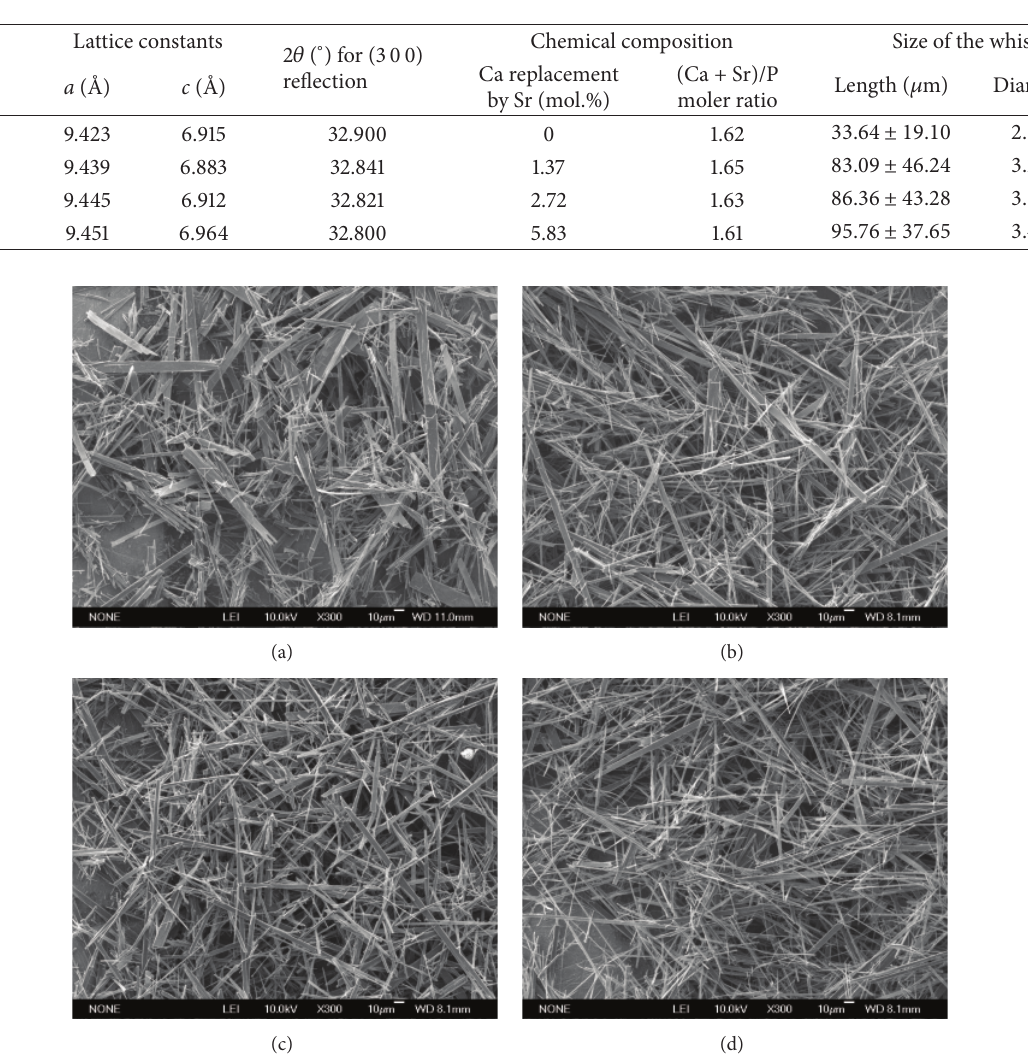
Figure 1: SEM images of the obtained HAp (a), Sr2.5HAp (b), Sr5HAp (c), and Sr10HAp (d) whiskers; Bar = 30 𝜇